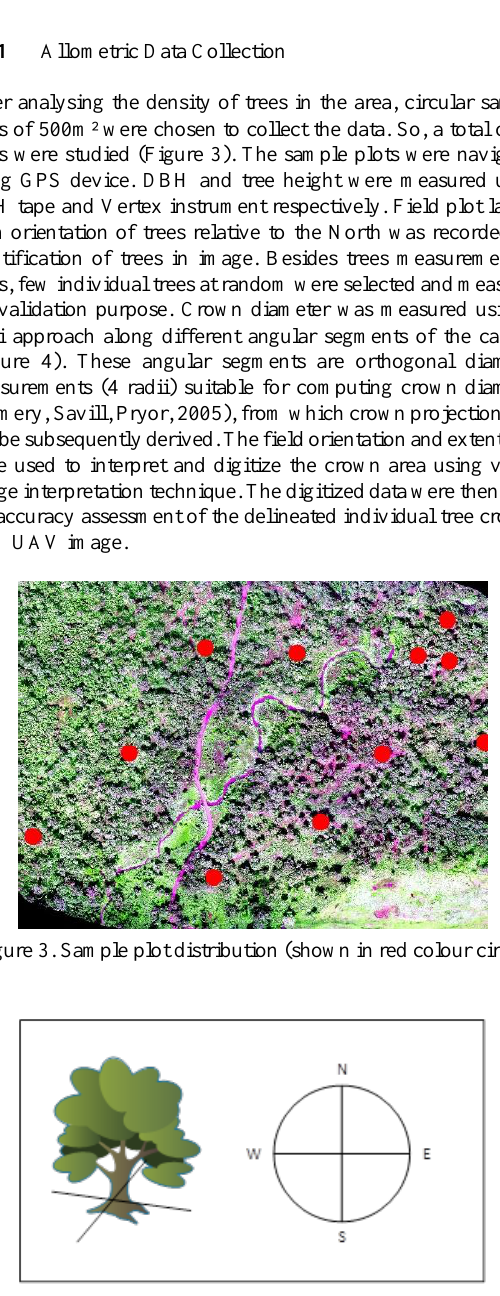
Figure 4. Four-radii approach for crown extent measurement